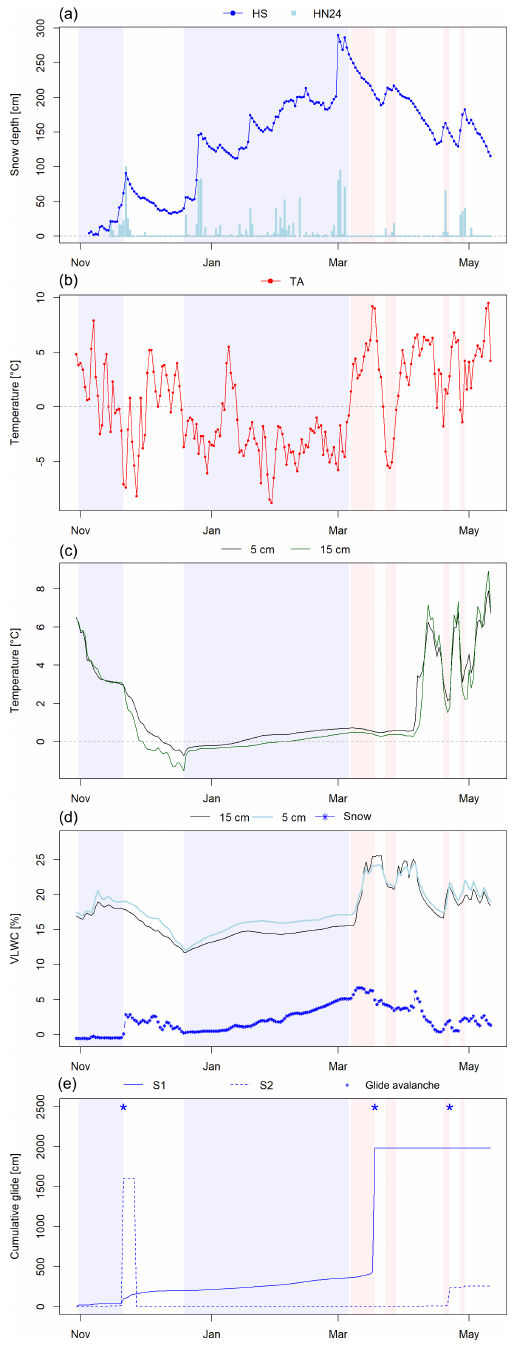
Figure 4. Site Pista Nera, winter season 2013–2014: (a) snow depth (HS) from AWS Weissmatten and new snow sum (HN24) from the manual snow measuring site Gabiet, (b) air temperature (TA) from AWS Weissmatten, (c) soil temperature, (d) VLWC measured within the soil and in the basal snowpack layer, (e) cumulative glide. Warm and cold periods are highlighted in orange and blue, respec- tively; periods reported in white are periods of no data analyses for S1, S2 or both (see Table 1 for details).